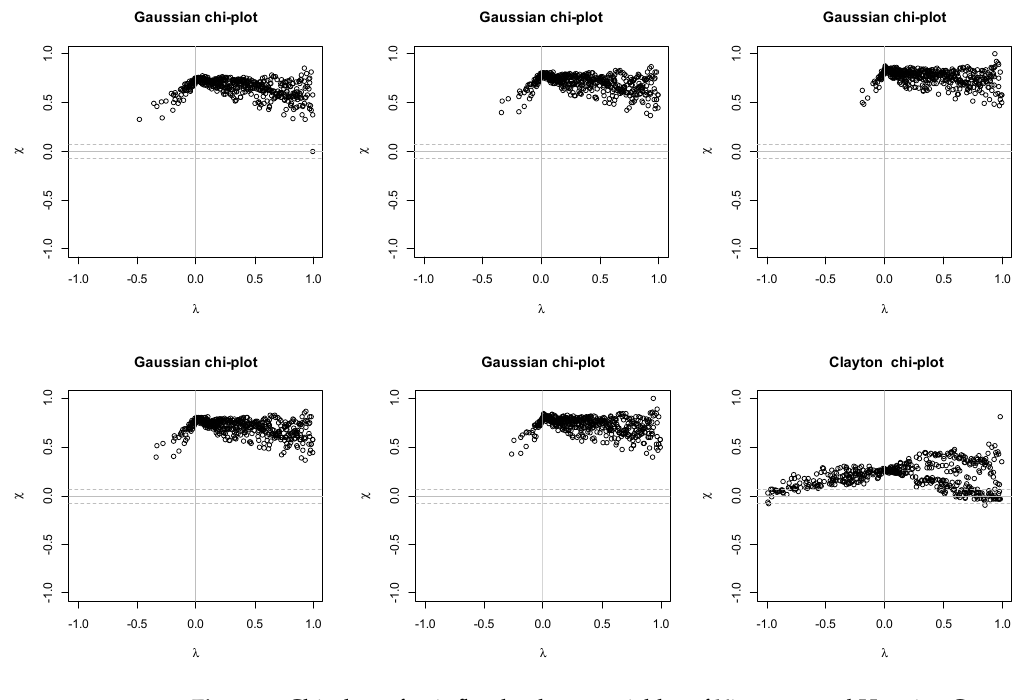
Figure 7. Chi-plots of pair flood volume variables of Xianyang and Huaxian County.